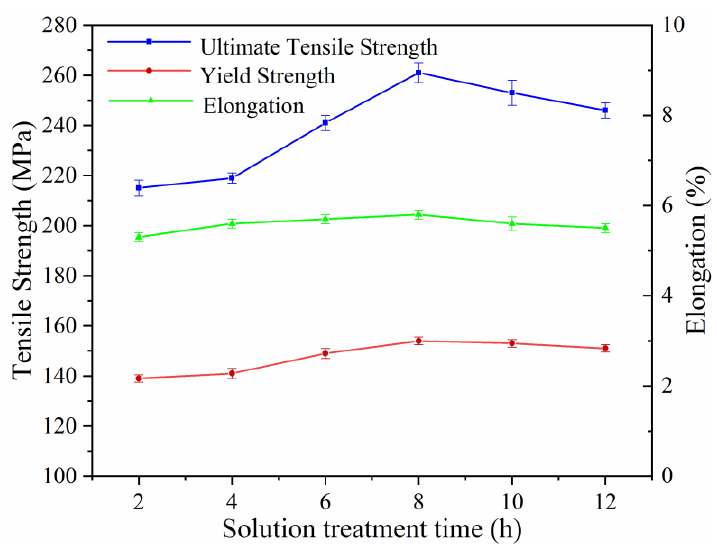
Figure 6. Mechanical properties of the aged Mg-2.0Nd-2.0Sm-0.4Zn-0.4Zr alloy with solution treat- ment for different times. ment for different